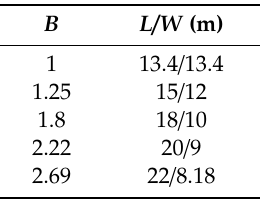
Table 2. The values of L and W in each